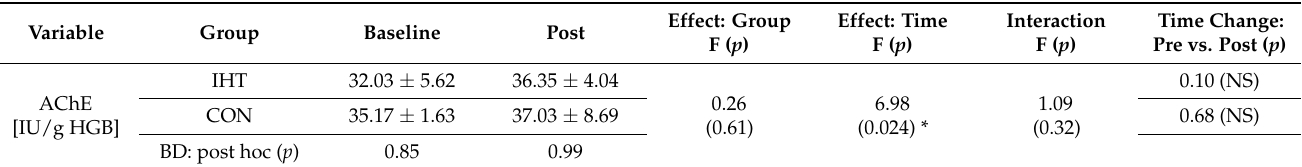
Table 7. Mean values ( ± SD) of acetylcholinesterase activity in rowers training in the hypoxia and normoxia (control) conditions before and after the